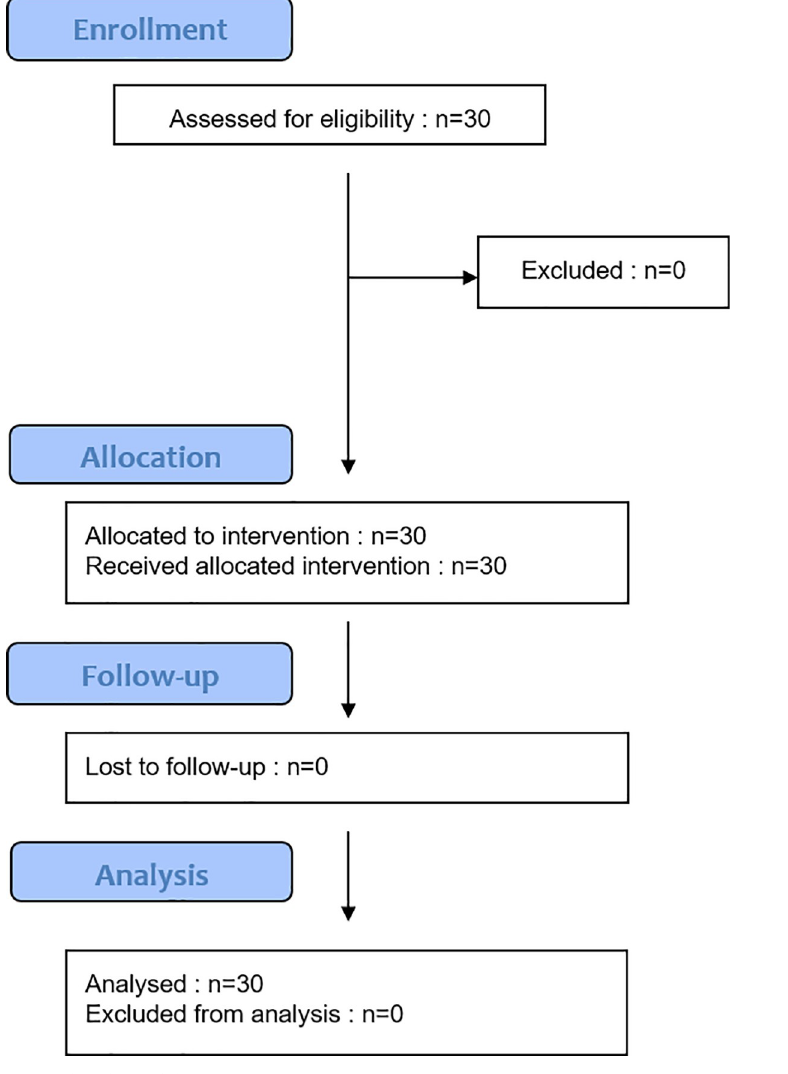
Fig 4. Flowchart of the